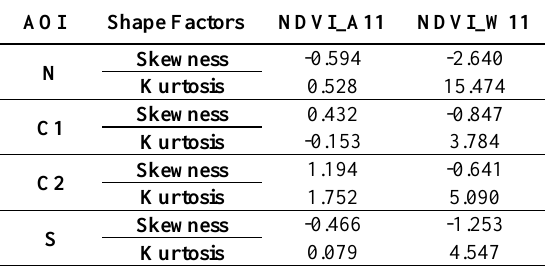
Table 4. Higher order moment results